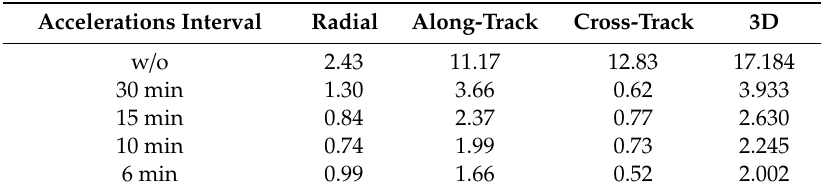
Table 6. The RMS precision of Luojia-1A with different piecewise constant accelerations intervals (Unit: cm).